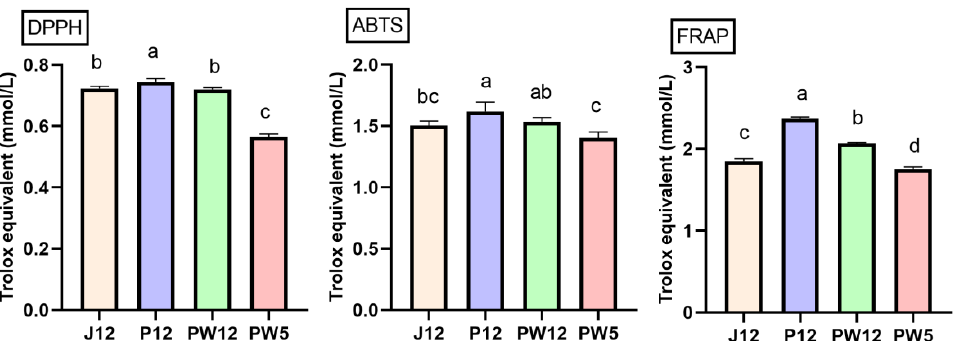
Figure 2. Antioxidant activity of the investigated wines. Values are the averages of three replicates and different alphabets indicate significant differences ( p < 0.05) according to Duncan test.